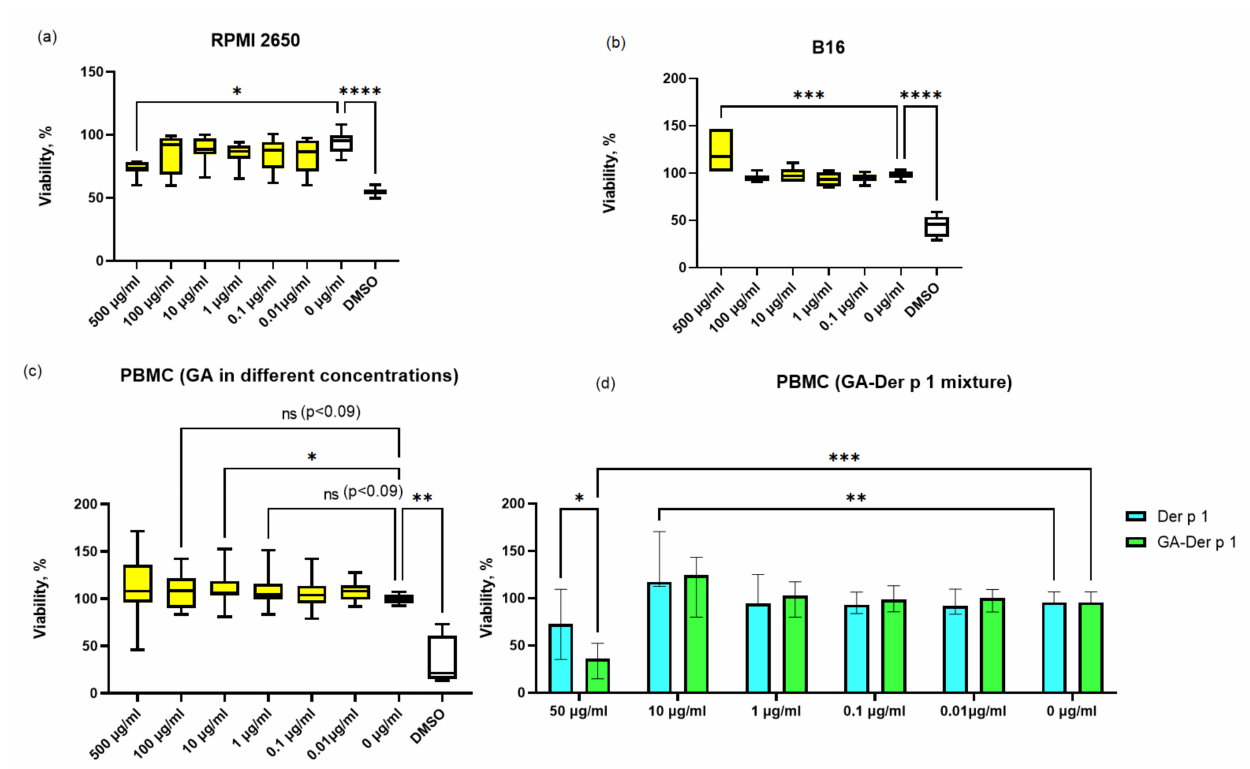
Figure 2. Effects of GA and Der p 1 on cell viability of different cell cultures. ( a ) effects of the GA on cell viability of RPMI-2650 cells. ( b ) effects of the GA on cell viability of B16 cells. ( c ) effects of the GA on cell viability of PBMCs. ( d ) effects of the Der p 1 and Der p 1–GA mixture on cell viability of PBMCs. * Indicates a significant difference ( p < 0.05); ** indicates a significant difference ( p < 0.01); *** indicates a significant difference ( p < 0.001); **** indicates a significant difference ( p <